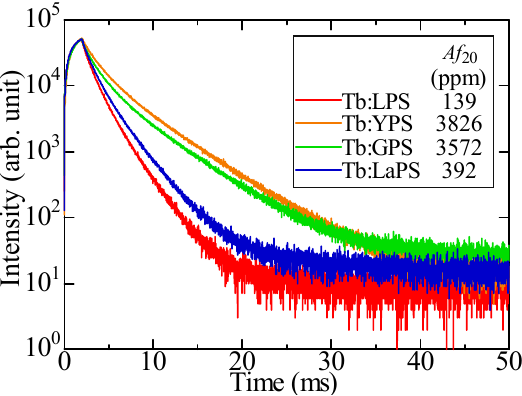
Figure 8. Afterglow profiles of Tb-doped LPS, YPS, GPS, and LaPS samples, with the Af 20 .